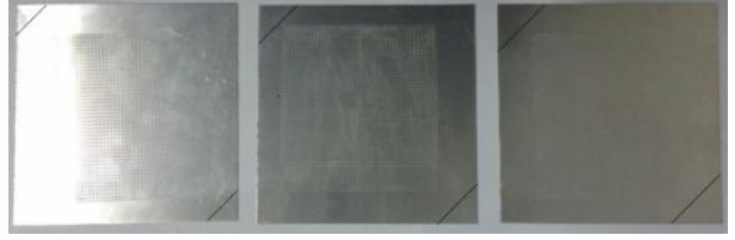
Figure 14. Samples before wrinkling.